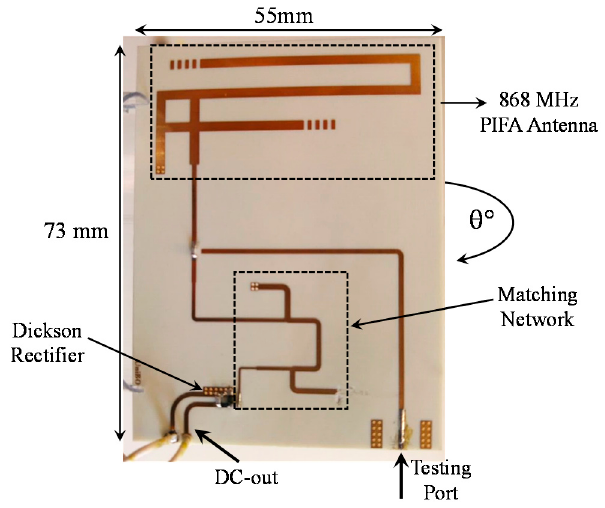
Figure 2. Rectenna prototype with highlighted different sections.